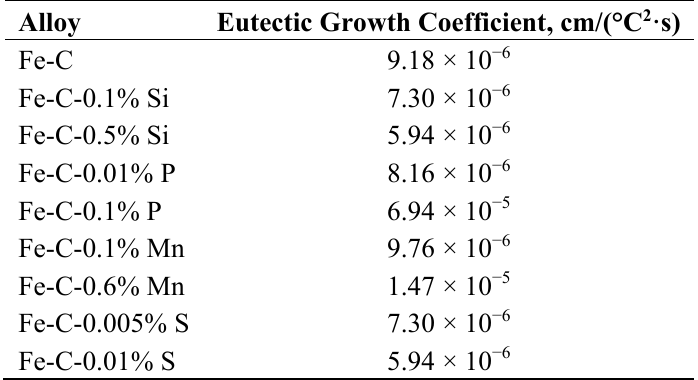
Table 3. Reported values for the eutectic growth coefficient, μ [30].